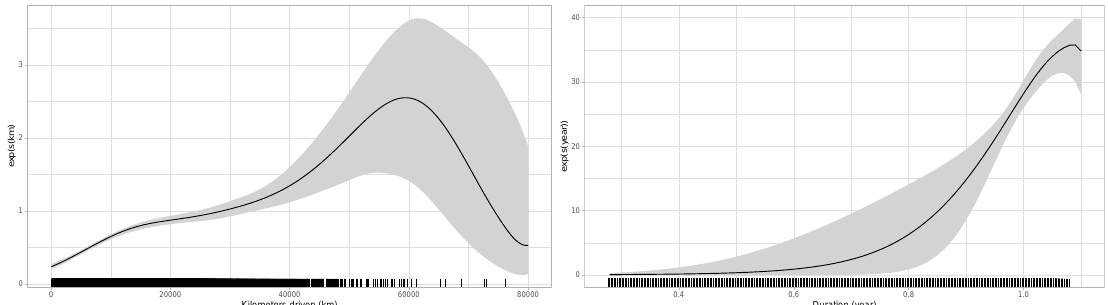
Figure 10. exp ( ˆ s 1 ( km )) and exp ( ˆ s 2 ( year )) from the GAMLSS with random effects model estimated with Canadian data.